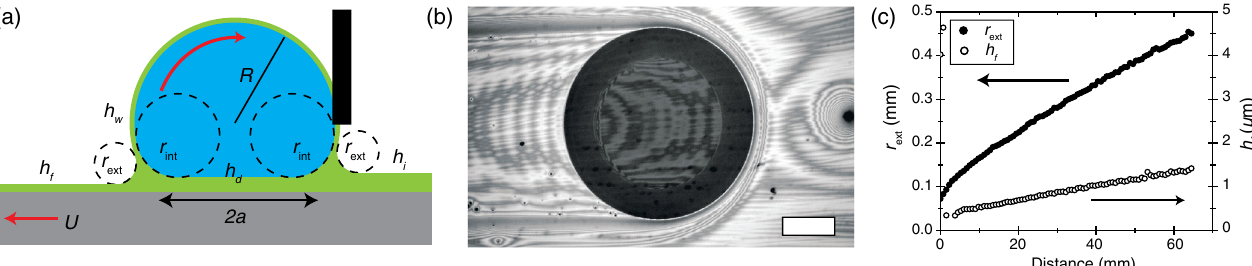
FIG. 3. (a) Schematic of the experimental setup used to study the lubricant dynamics. The substrate is moved while the droplet is held in place by a capillary tube, allowing for measurement of the wetting ridge and lubricant thicknesses in various positions. (b) RICM image demonstrating the lubricant profile around a moving droplet (scale bar ¼ 1 mm). See the Supplemental Material Video S1 [27] for lubricant dynamics visualized using RICM. (c) Typical experimental measurement of h infused surface. The data for the first two open circles refer to initial thickness h